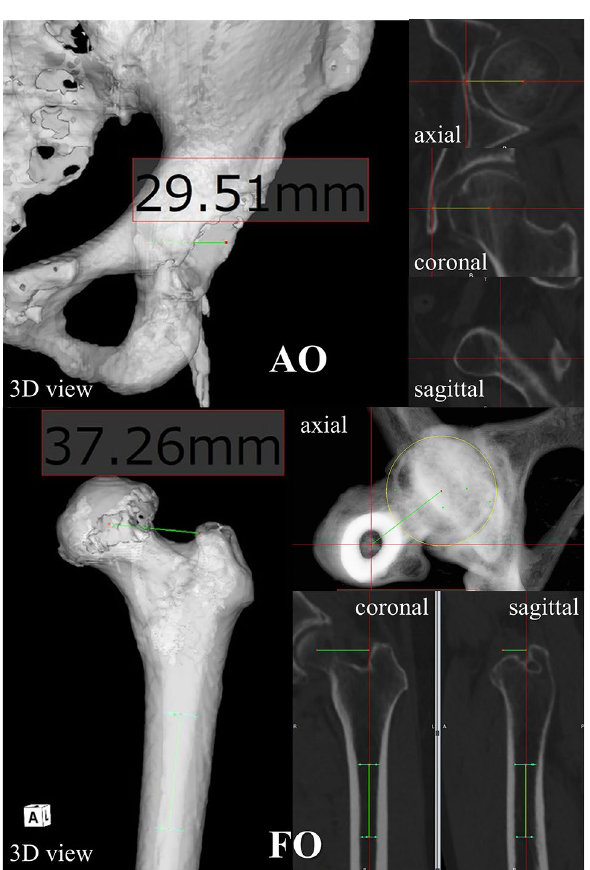
Figure 3. Assessment of acetabular offset (AO) and femoral offset (FO) using the 3D